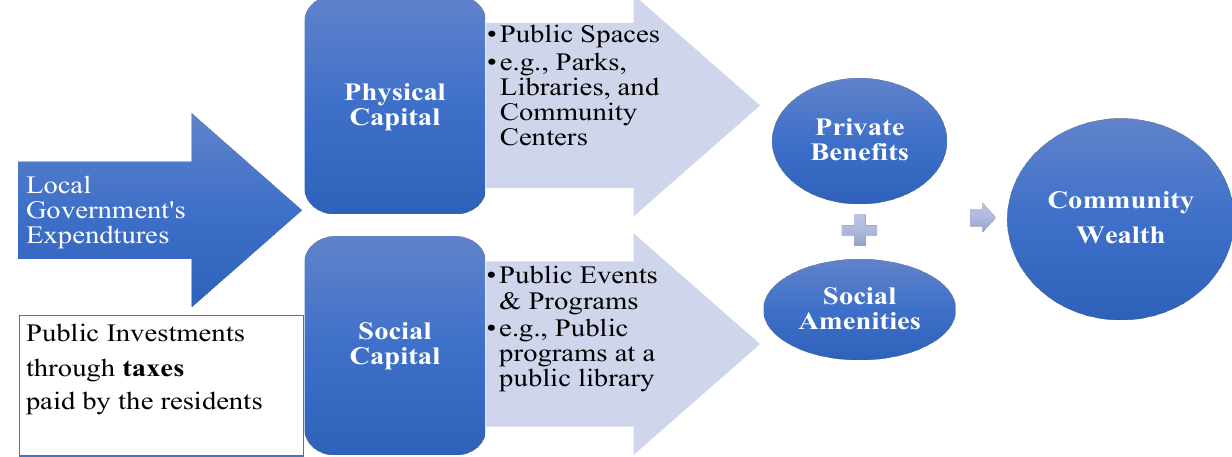
Figure 1. Conceptual logic: sources of social amenities from public investments.